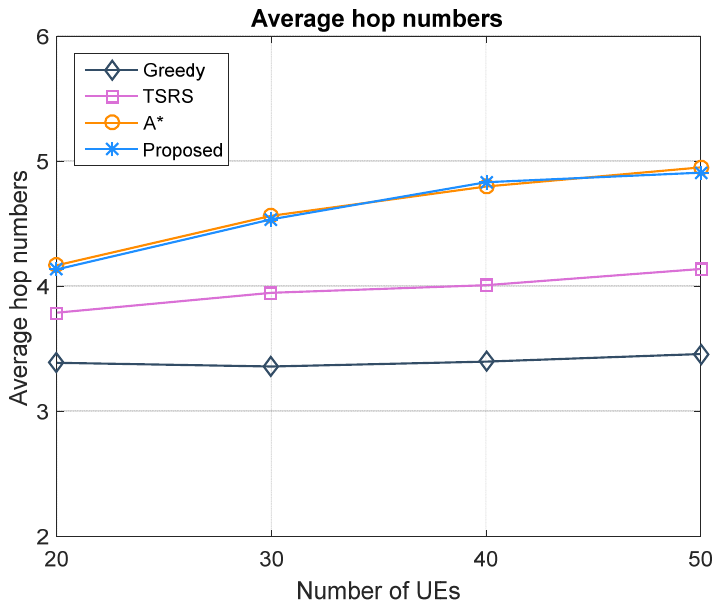
Figure 16. Hop count vs. number of UEs.